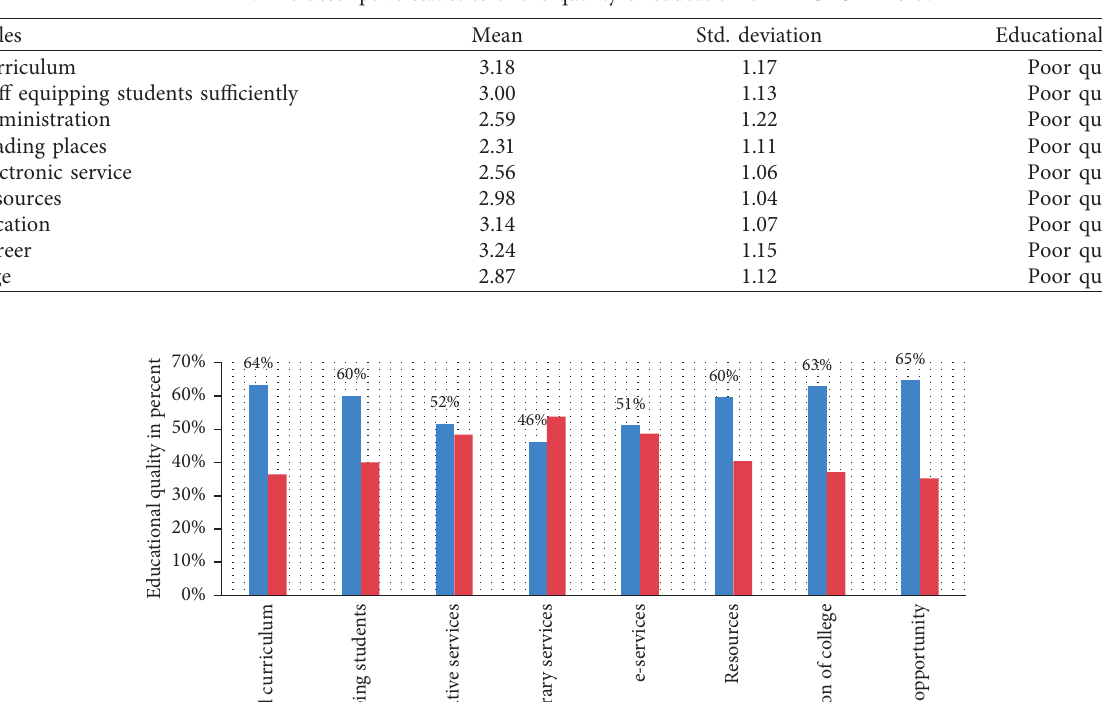
Table 2: The descriptive statistics of the quality of education of AMCHS in